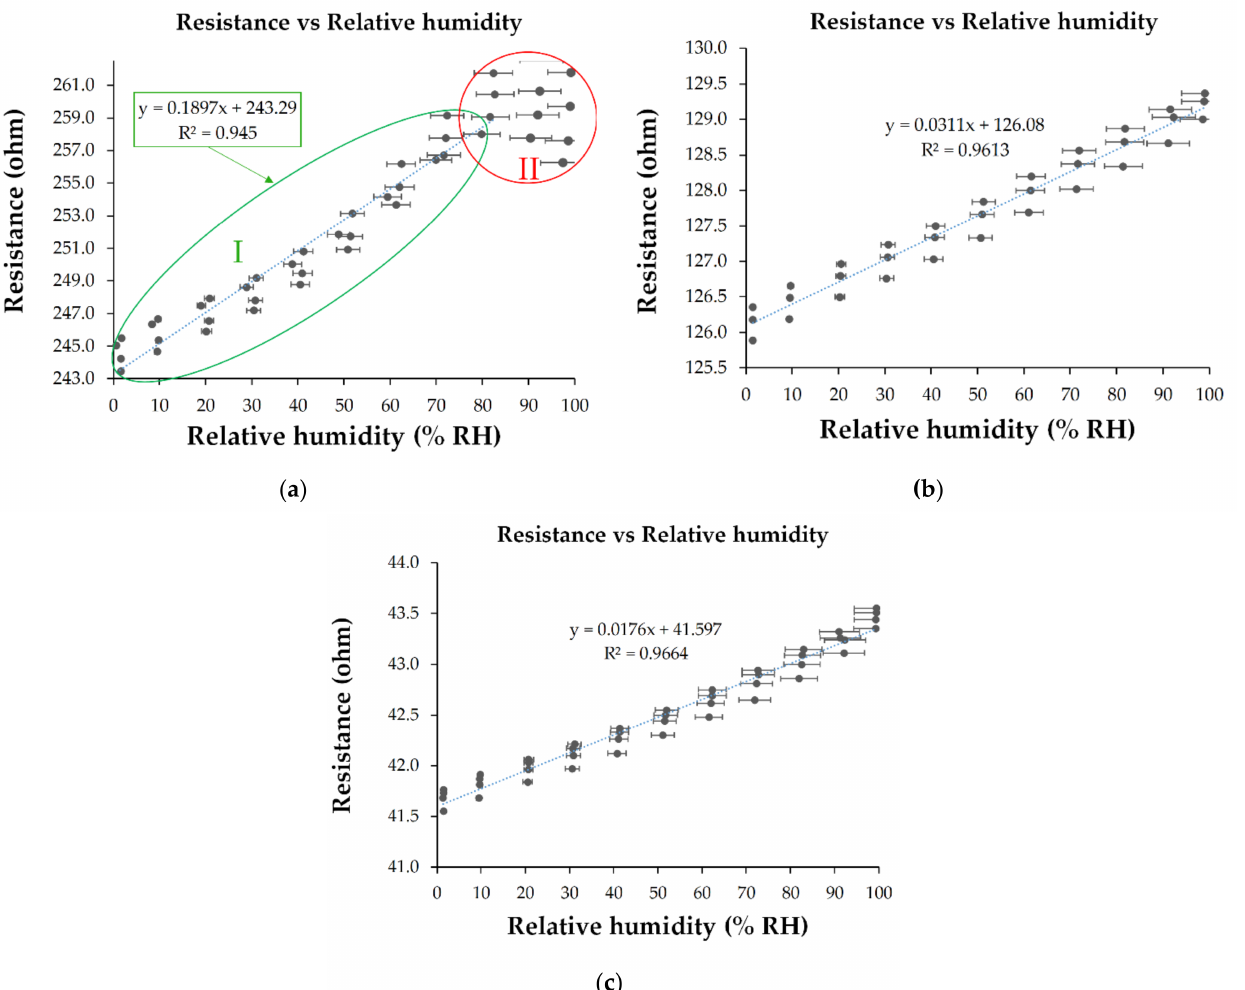
Figure 12. The transfer function of the sensor ( a ) T1, ( b ) T2, and ( c ) T3 in humid nitrogen (RH =